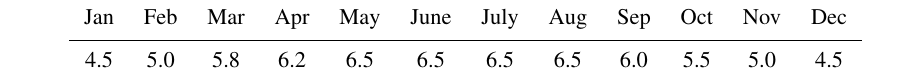
Table 1. Average climatological monthly adiabatic lapse rate from Rolland (2003) for the Alpine region (expressed in Kkm − 1 ).